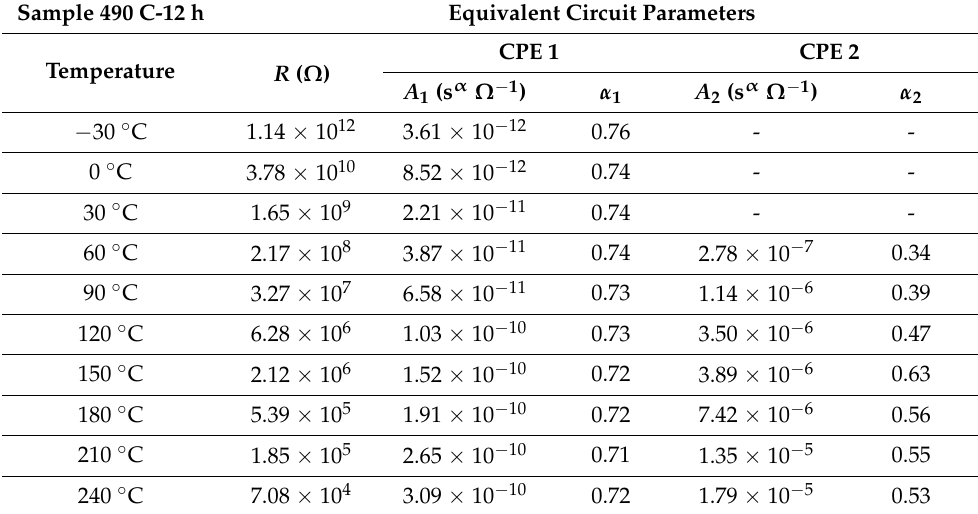
Table 2. The fitting parameters of impedance spectra at various temperatures for the glass-ceramic prepared at 490 ◦ C for 12 h. Sample 490 C-12 h Equivalent Circuit